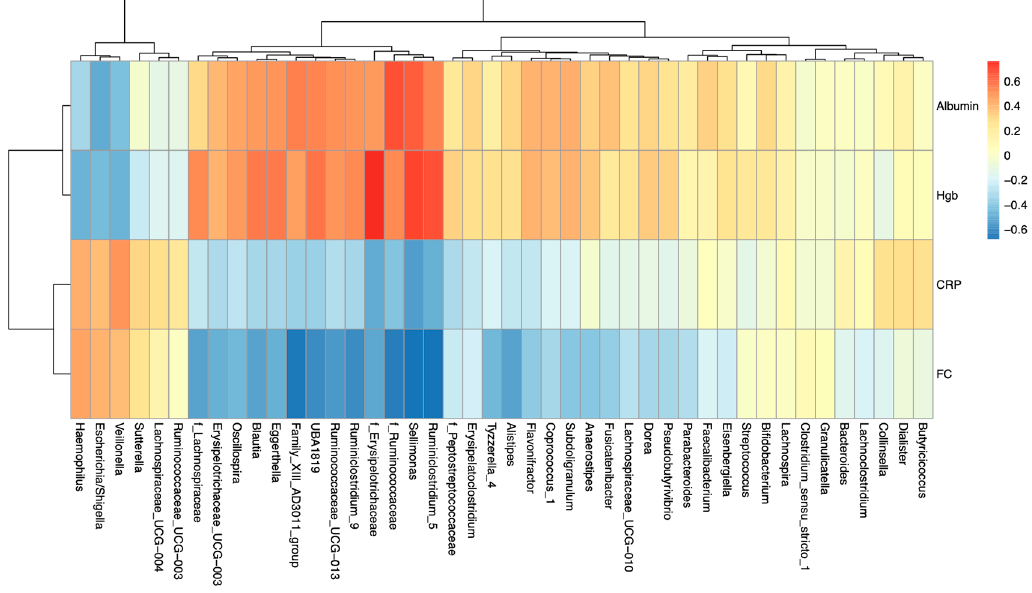
Figure 7. Correlation of fecal and serum markers of disease with bacterial genera. Genera Sellimonas and Ruminiclostridium positively correlated with serum Hgb and albumin levels, and negatively correlated with CRP and FC. Genera Veilonella and Escherichia / Shigella negatively correlated with serum Hgb and albumin levels. Hgb—hemoglobin, CRP—C-reactive protein, FC—fecal calprotectin